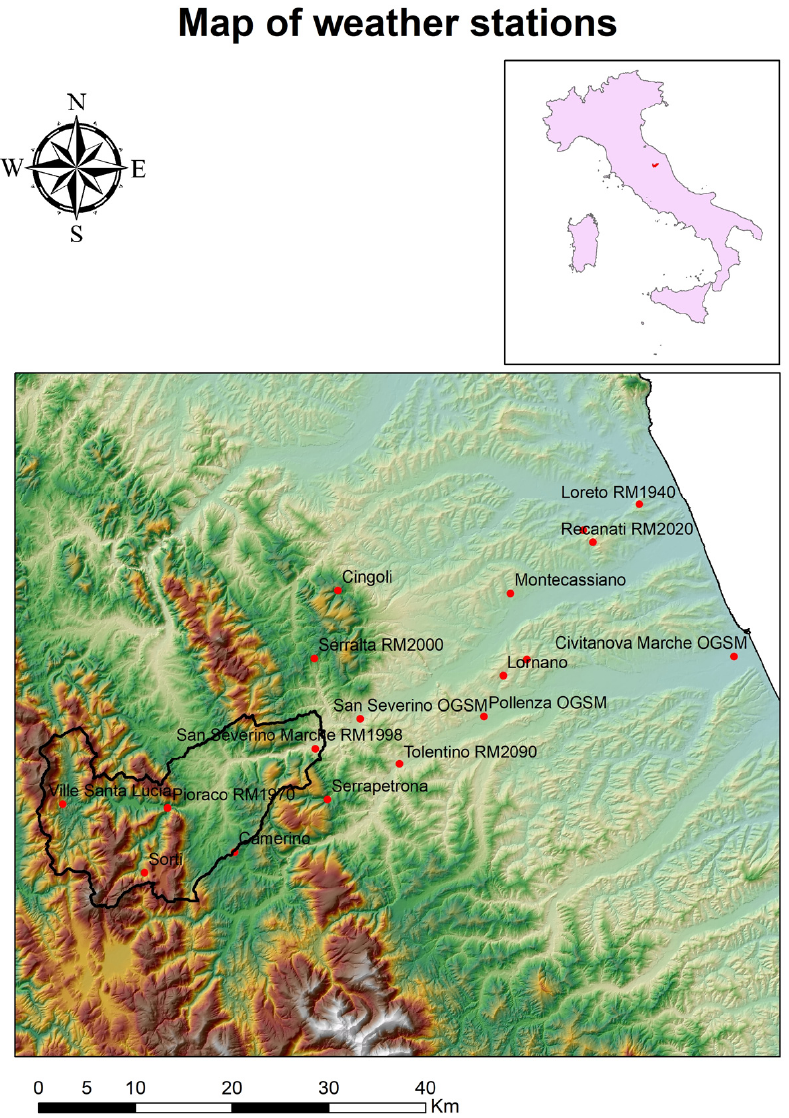
Figure 2. Map of weather stations.